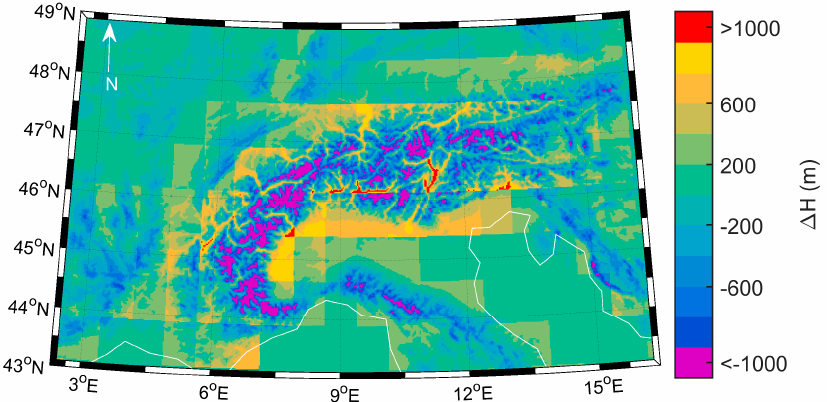
Figure 2. Histogram of orographic differences between ERA-Int and COSMO for the studied area.